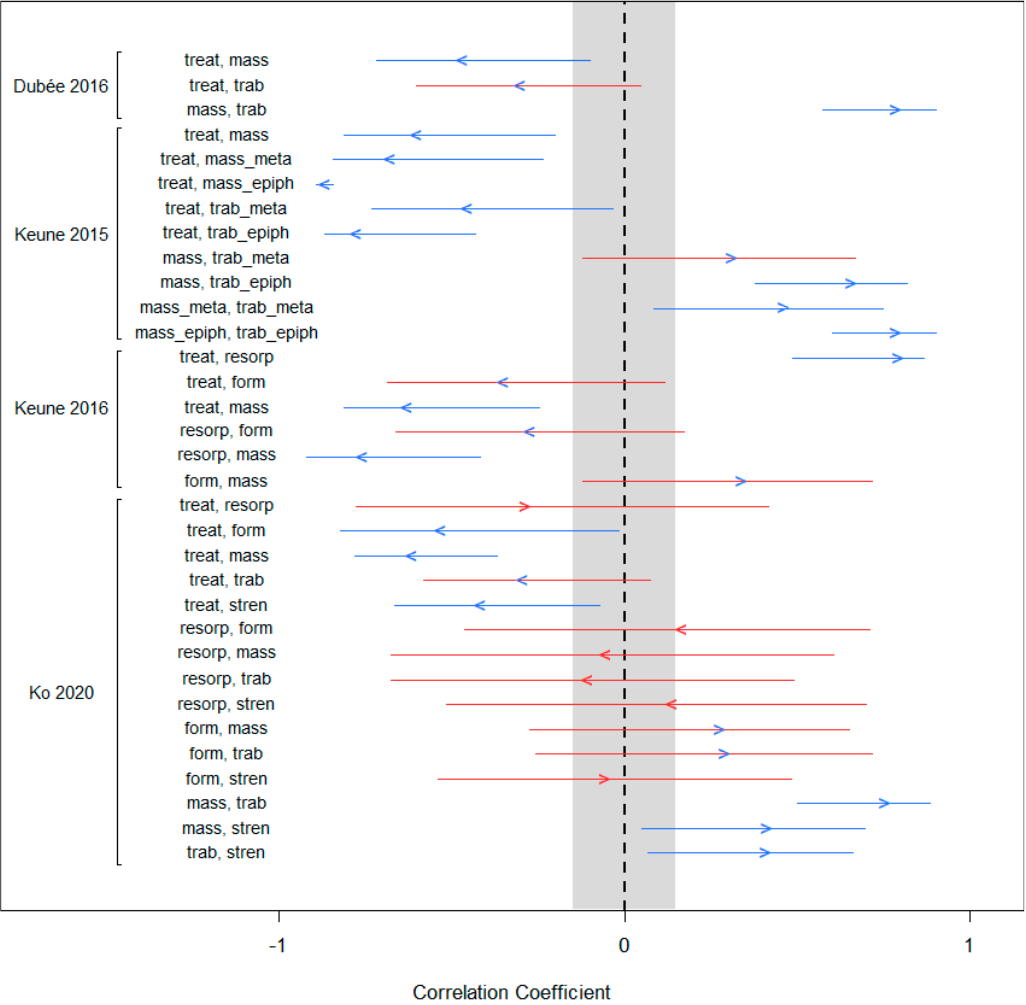
Figure 2. Correlations and 95% confidence intervals for testing marginal associations. The grey band represents the no-effect zone, or the zone in which a point estimate is considered indistinguishable from zero. Arrows point in the direction of expected correlation, above or below zero; blue arrows are those of sufficient magnitude to be considered non-zero (outside of the grey band), while red arrows are of insufficient magnitude to be considered non-zero (inside the grey band). Blue interval bands exclude 0 while red interval bands include 0.